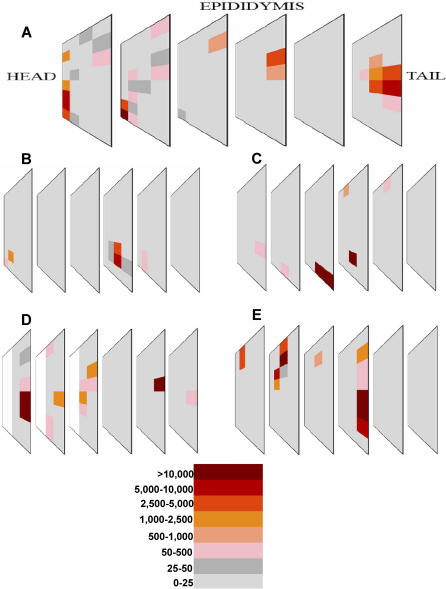
Distribution of C755G Mutants in Dissected Human TestesFor dissection details, see Figure 1 and Figure S2. In every case, the orientation of the testis is given relative to the head and tail portions of the epididymis. Each panel consists of six slices, each divided into 32 pieces, with exceptions noted below. The color code shows the number of mutant molecules per million genomes. (A) Testis 374–1. (B) Testis 374–2. (C) Testis 854–1, Upper left (UL) portion (Figure S2). The sizes of the 192 pieces are ∼1/4 the size of the pieces shown in the other panels. (D) Testis 854–1 Upper right + Tail half portions (UR+TH). The vertical white rectangles (pieces 1–16 in the first three slices) indicate the source of the UL portion shown in panel (C). (E) Testis 854–2.